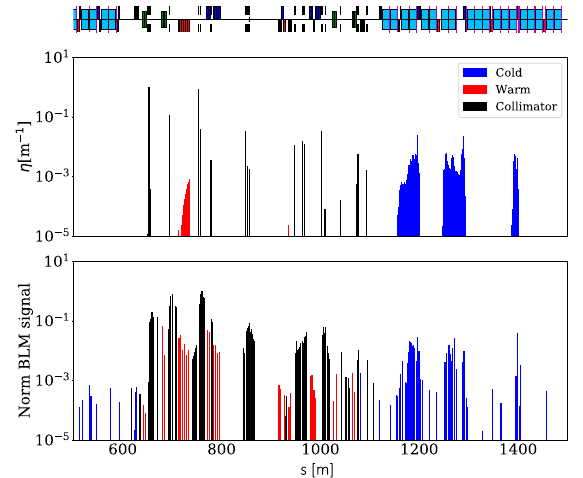
FIG. 9. IR7 horizontal B1 simulated (top) and measured (bottom) loss map for both TCP jaws at 5 σ .